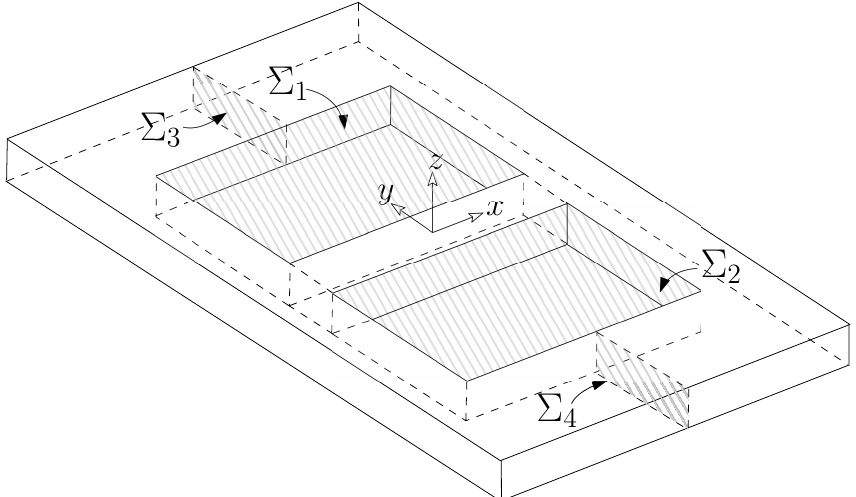
Figure 17. Cut surfaces used for determining magnetic fluxes indicated in Table 1 ( Σ 1 , Σ 2 ) and eddy–current indicated in Table 2 ( Σ 3 , Σ 4